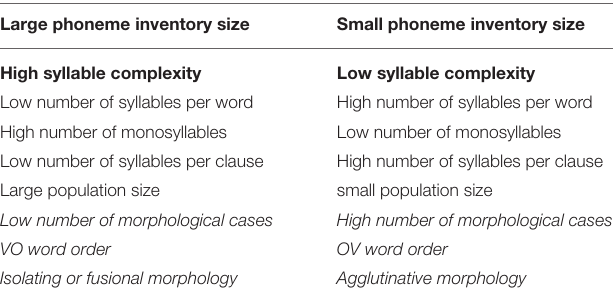
TABLE 2 | Relationships between phoneme inventory size, linguistic structures, and population size (results of previous studies in italics). Large phoneme inventory